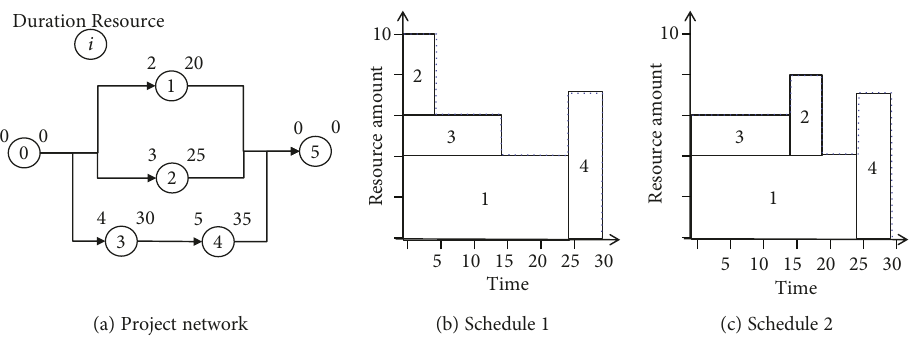
Figure 1: Simple